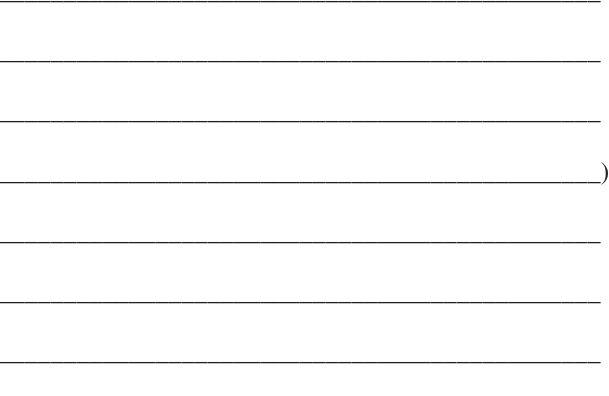
FIG. 8. Excerpt from a textbook [11] that contains diagrams for sound standing waves represented by two intertwining sinusoidal curves. This excerpt is reproduced by permission: From SERWAY/FAUGHN/VUILLE. Enhanced College Physics (with PhysicsNOW), 7E. © 2006 Brooks/Cole, a part of Cengage Learning, Inc. Reproduced by permission. www.cengage.com/